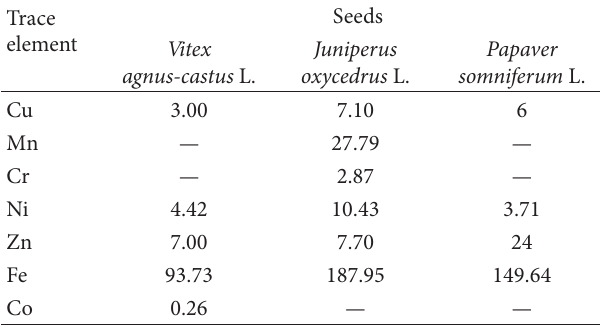
— — T 3: e levels of metals in seed samples (mg/kg). Trace element